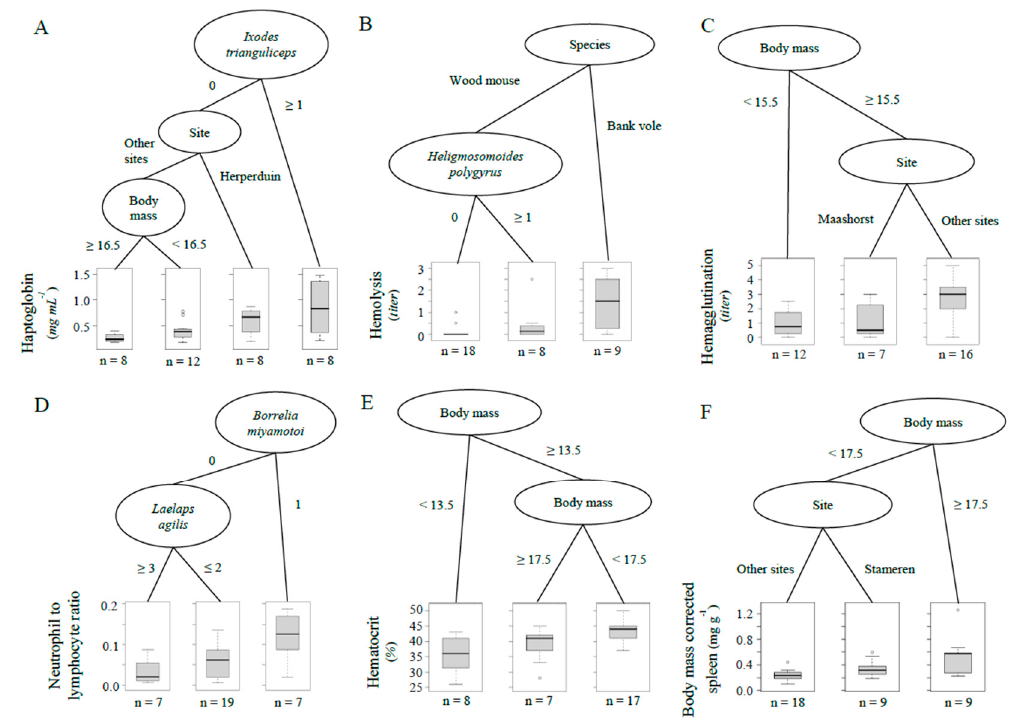
Figure 1. Regression tree showing the most parsimonious split for ( A ) haptoglobin, ( B ) hemolysis, ( C ) hemagglutination, ( D ) neutrophil to lymphocyte ratio, ( E ) hematocrit, and ( F ) body-mass corrected spleen size. Boxplots show the spread of values (median and quantiles) within each group identified by the di ff erent splits in the tree. Sample size for each group is given underneath the boxplots. Body mass is given in grams.